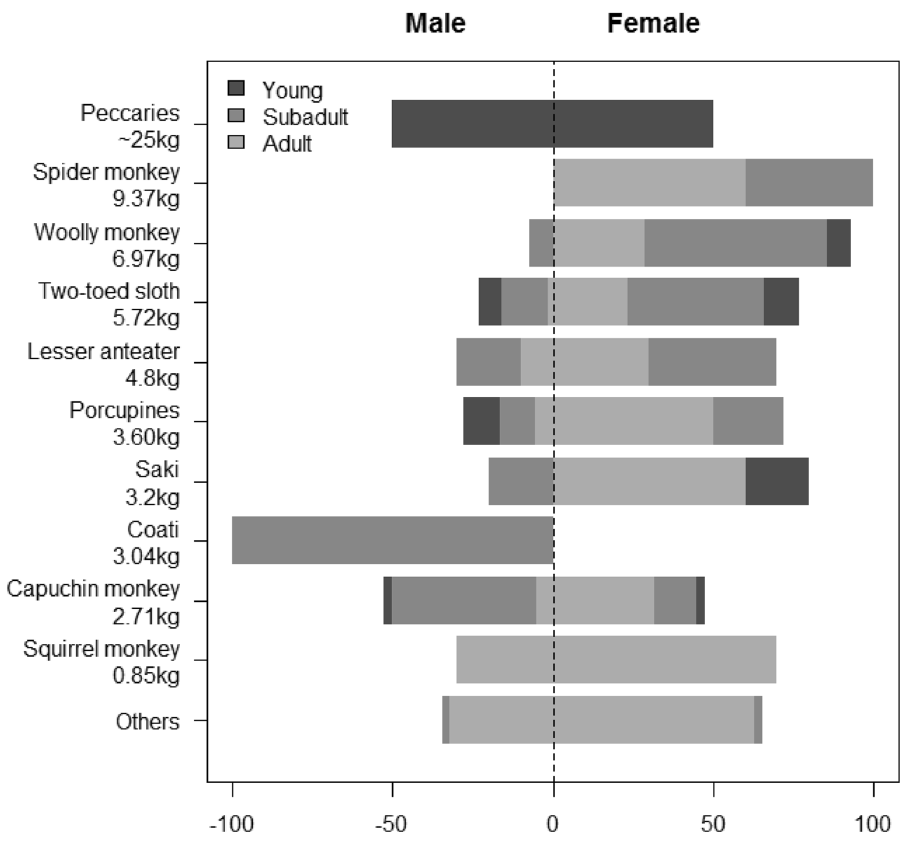
Figure 2. Prey age classes consumed by either male and female harpy eagles. The 10 most important prey species (representing > 80% of the total) are ordered top to bottom by adult body mass. Prey age class (stacked horizontal bars) are indicated according to the legend. Male harpy eagles are less likely to pursue adult prey, particularly in large-bodied prey